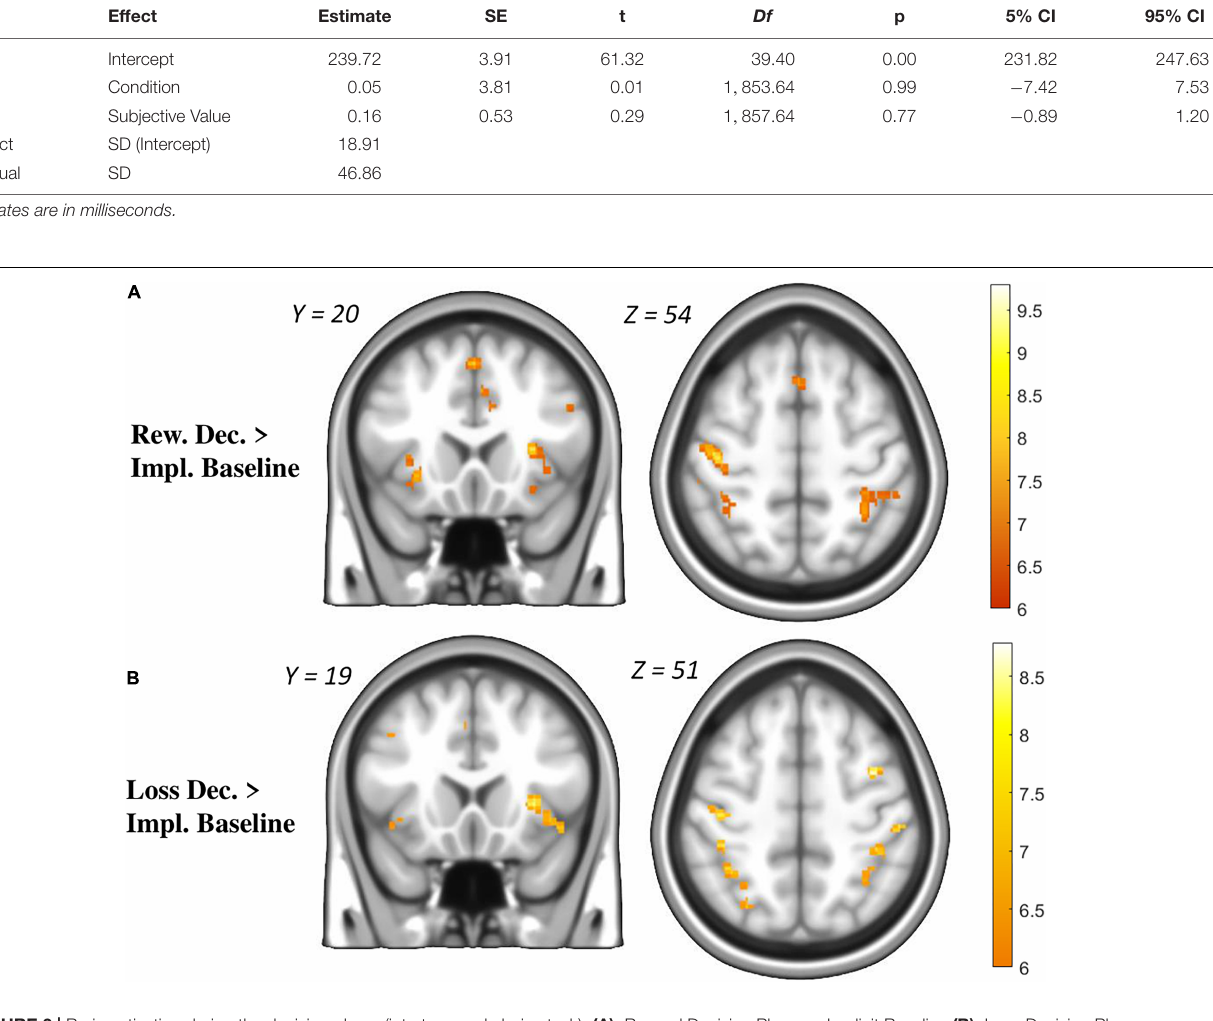
Frontiers in Systems Neuroscience |